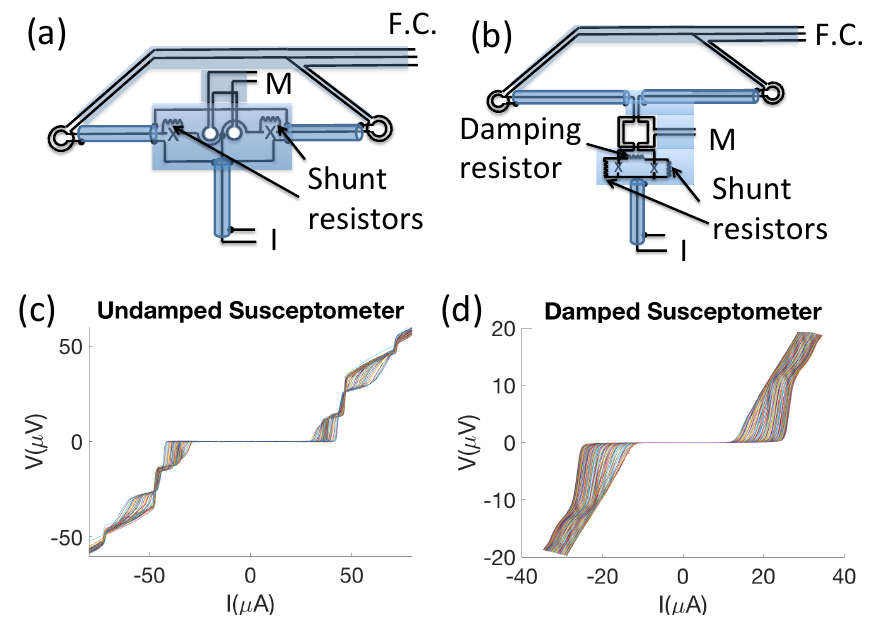
Figure 1. Two types of susceptometer layouts: ( a ) That of Huber et al. [14,15], without a damping resistor, and ( b ) that of Gardner et al., [12] with a damping resistor. I labels the current leads, M the modulation coil leads, and F . C . the field coil leads. The Josephson junctions are indicated by X s. The semi-transparent regions indicate superconducting shields. Superconducting coaxial leads connect the central regions with junctions and modulation coils to the pickup loop/field coil pairs to the left and right. ( c ) Current–voltage (IV) characteristic for an undamped susceptometer at various magnetic fluxes, and ( d ) IVs for a damped